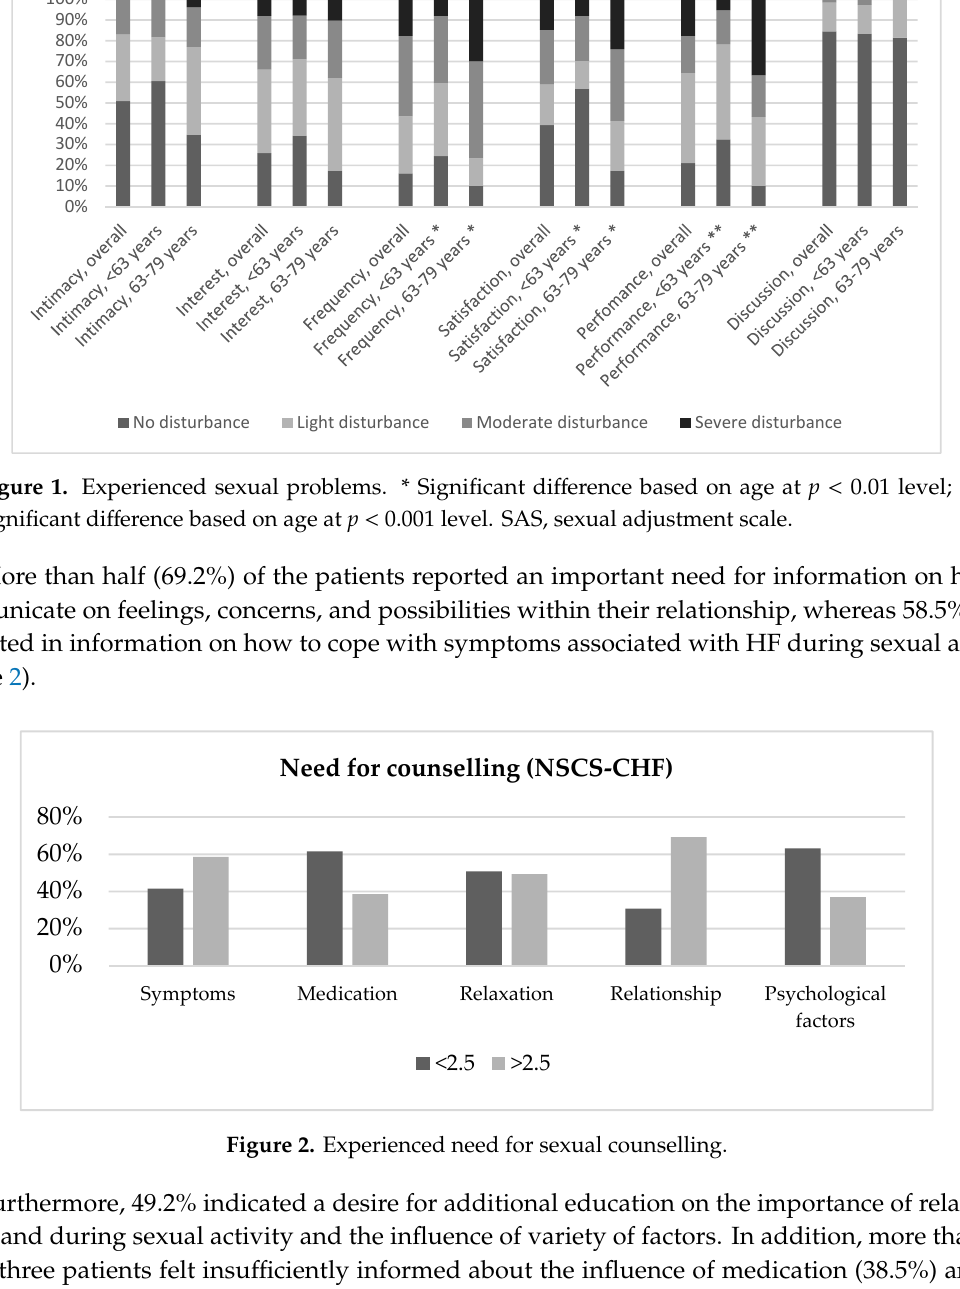
Figure 2. Experienced need for sexual counselling.